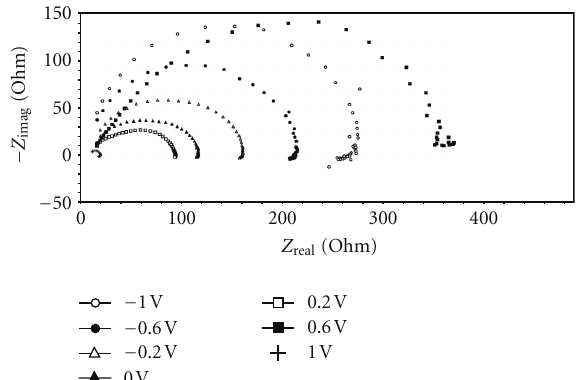
Figure 9: Nyquist impedance spectra of Al/n-Si/PANI-DBSA/Ag heterojunctions under illumination (0.09 W/cm 2 ) at di ff erent potentials.